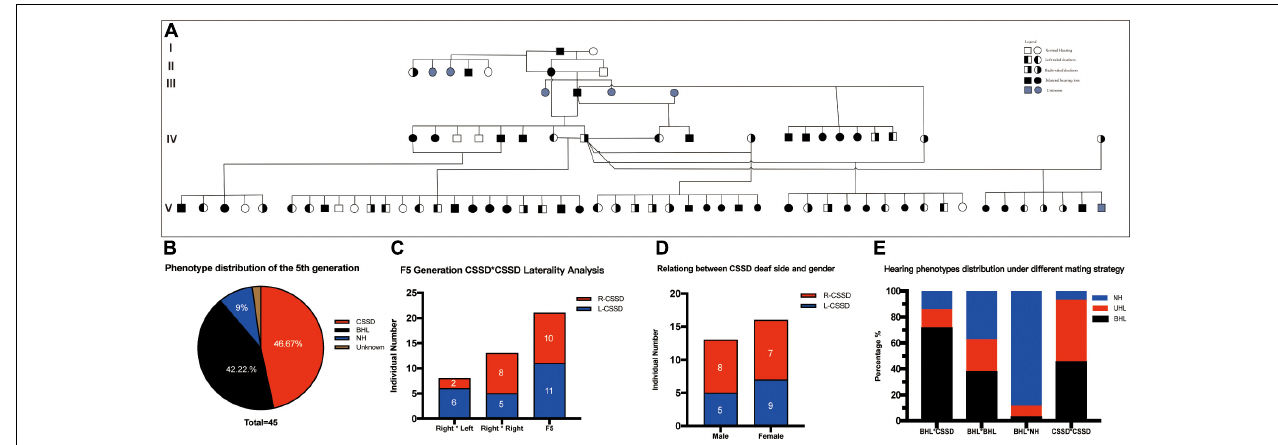
FIGURE 1 | Congenital single-sided deafness (CSSD) pedigree information. (A) CSSD pedigree information that consists five generations. (B) Hearing phenotype distribution of the fifth generation with different mating strategies. (C) Relation of the deaf side between CSSD siblings and their parents. (D) Relation between CSSD deaf side and gender. (E) Hearing phenotypes distribution under a different mating strategy. L-CSSD, left-sided CSSD; R-CSSD, right-sided CSSD. The individuals with red star in Panel (A) were selected to do whole genome resequencing.